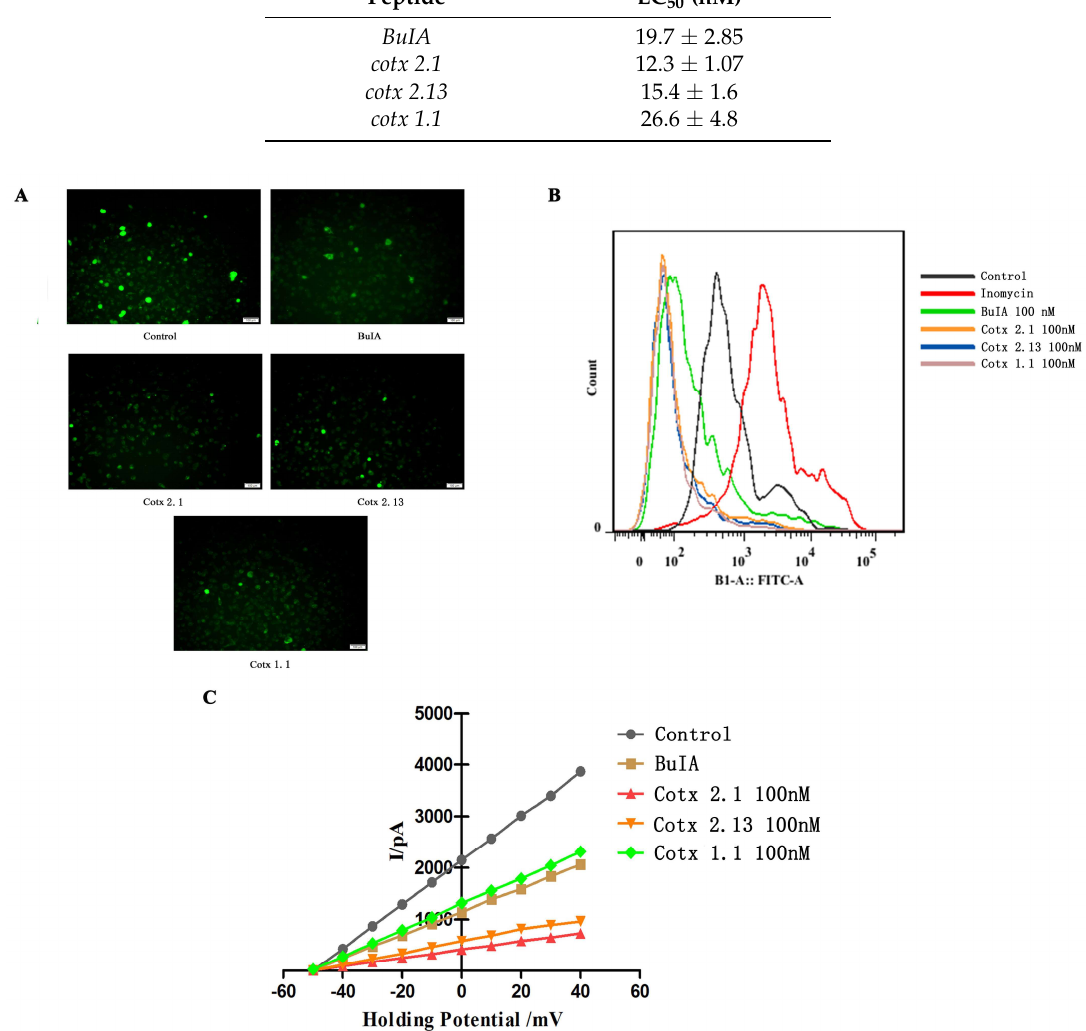
Figure 2. Activity of BuIA and its analogues on Ca 2+ levels in the dorsal root ganglion (DRG) neuron cells: ( A ) immunofluorescence images of calcium in the DRG neuron cells that were treated with BuIA and its analogues: BuIA and all of the analogues significantly weakened the fluorescence intensity of intracellular calcium ion staining; ( B ) flow cytometry results of calcium in the DRG neuron cells that were incubated with BuIA and its analogues: BuIA and all of the analogues significantly reduced the calcium concentration in DRG cells; ( C ) the results of the calcium channel state in the DRG neuron cells. The patch clamp was used and the cells were treated with BuIA and its analogues: BuIA and all of the analogues inhibited the calcium channel on the DRG cell surface. The inhibitions of cotx 2.1 and cotx 2.13 were significantly higher than BuIA and cotx 1.1 , and the differences between BuIA groups and cotx 1.1 groups had no statistical significance. Table 2. The affinity of BuIA or its analogues with functional α7 nicotinic acetylcholine receptor (nAChR).